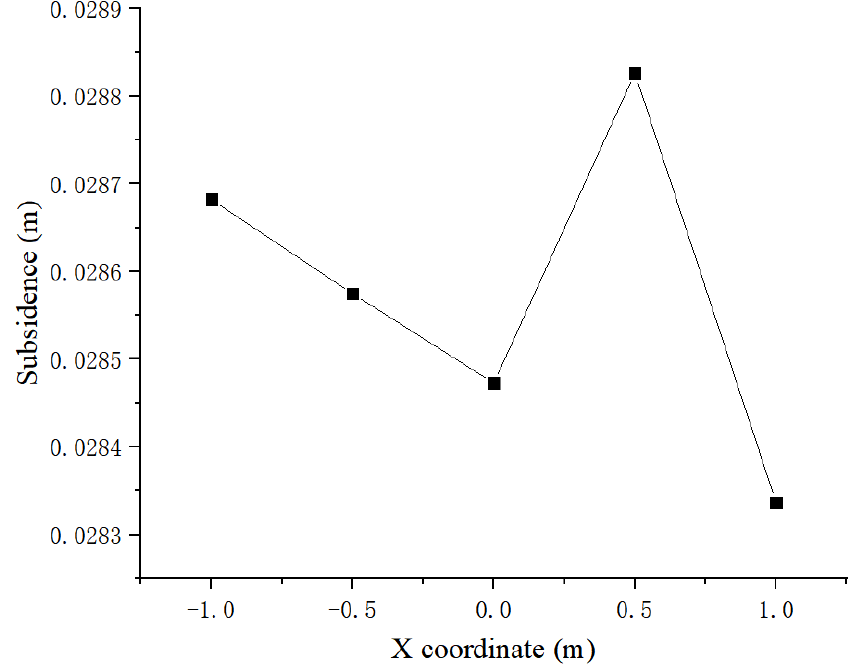
Figure 24. Variation of wall subsidence at 14.625 m under different load positions.